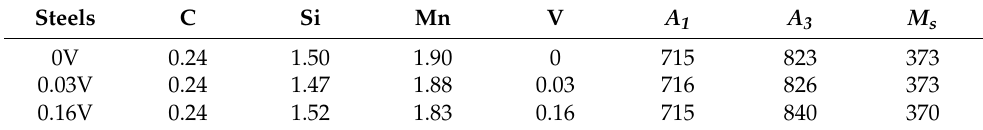
Table 1. Chemical compositions (wt%) and critical temperatures ( ◦ C) of the three experimental steels. Steels